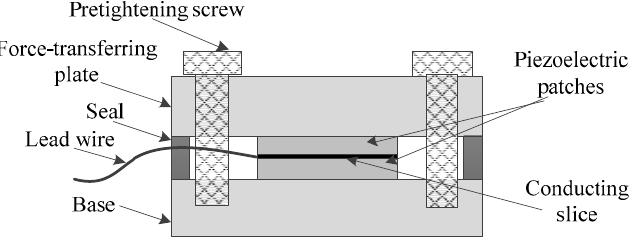
Figure 6. The simplified schematic of the common uniaxial piezoelectric sensor.